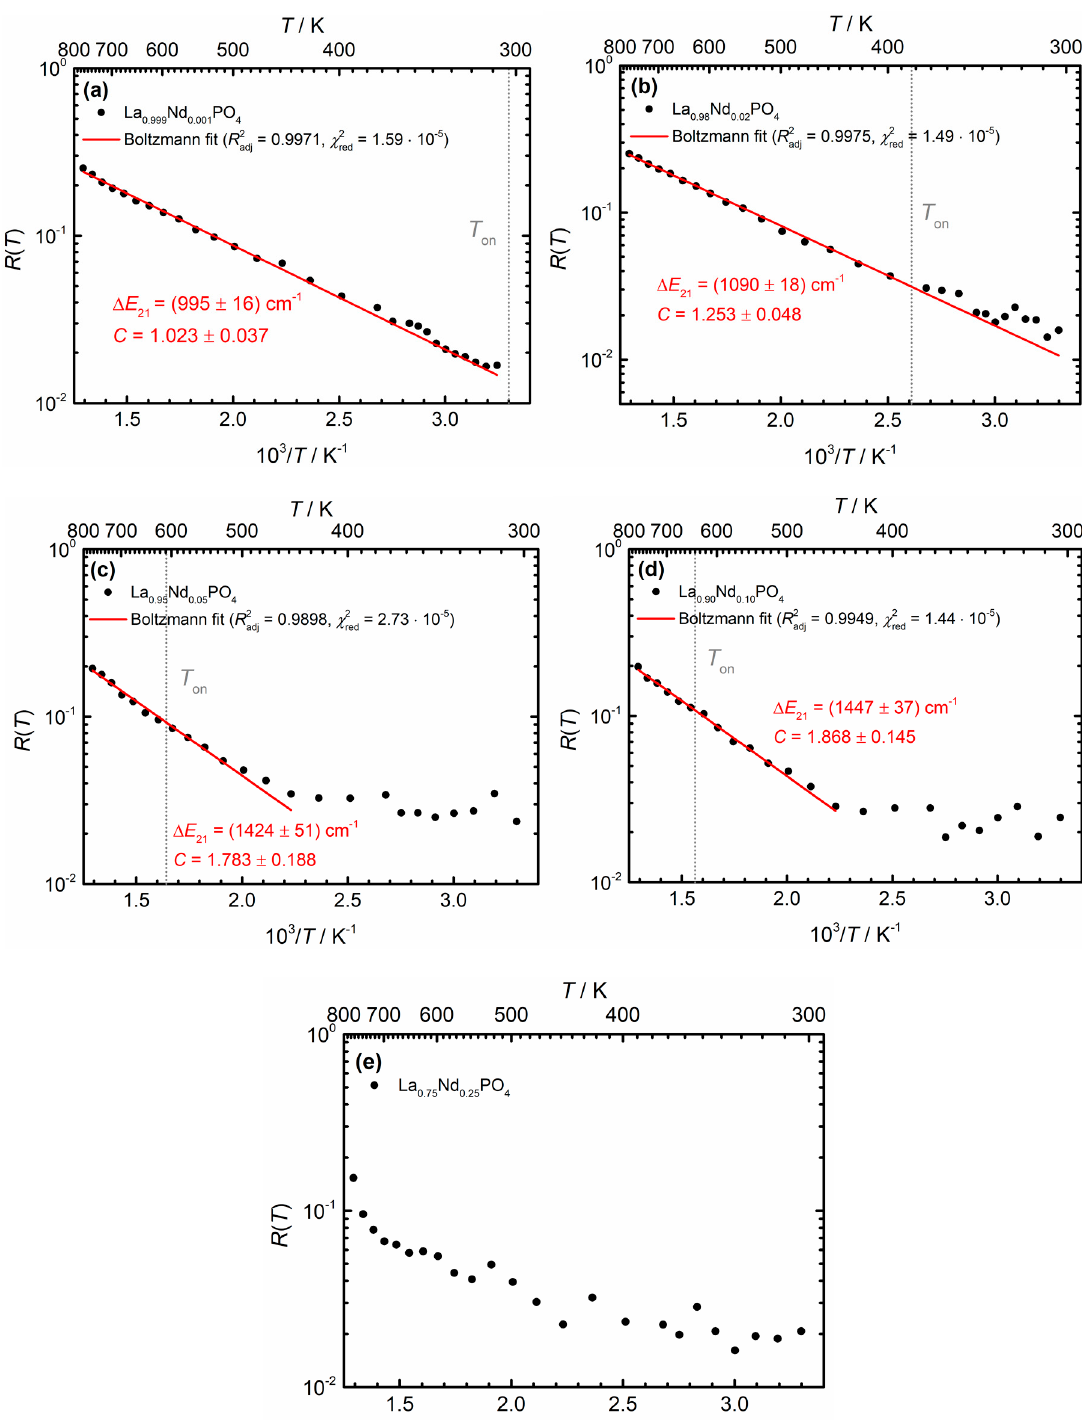
Figure 9. Semi-log plots of the temperature-dependent luminescence intensity ratio (LIR) between the 4 F 5 / 2 → 4 I 9 / 2 - and 4 F 3 / 2 → 4 I 9 / 2 -related emission of Nd 3 + in ( a ) microcrystalline La 0.999 Nd 0.001 PO 4 , ( b ) nanocrystalline La 0.98 Nd 0.02 PO 4 , ( c ) La 0.95 Nd 0.05 PO 4 , ( d ) La 0.90 Nd 0.10 PO 4 and ( e ) La 0.75 Nd 0.25 PO 4 . The NdPO 4 nanocrystals were excluded from the analysis due to dominance of blackbody background already above 100 ◦ C. Least-squares fits to the Boltzmann calibration law (see Equation (5)) are indicated by red solid lines together with the relevant statistical figures of merit. The predicted onset temperatures for Boltzmann equilibrium based on the decay analysis in Section 3.3 (see Figure 5a and Table 2) are also indicated.